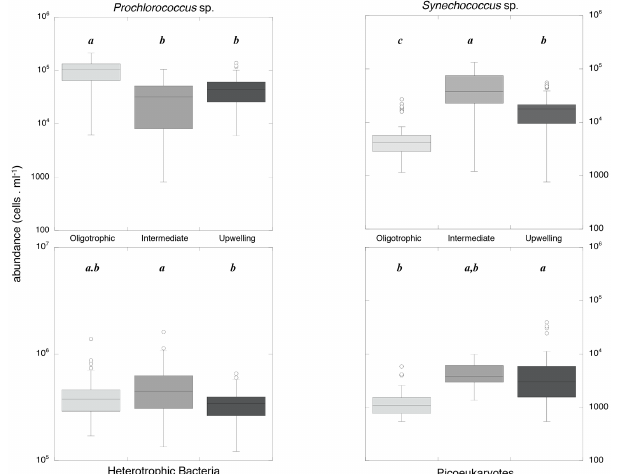
Figure 4. Box plots showing the distribution percentage of dead phytoplankton cells (%DC) of the different phytoplankton group in the sampled zones. The boxes present the lower and upper quartiles, median, minimum, and maximum values, and outliers. The boxes showing the same letter do not have significantly different mean values (Mann–Whitney–Wilcoxon test, p < 0 . 005).